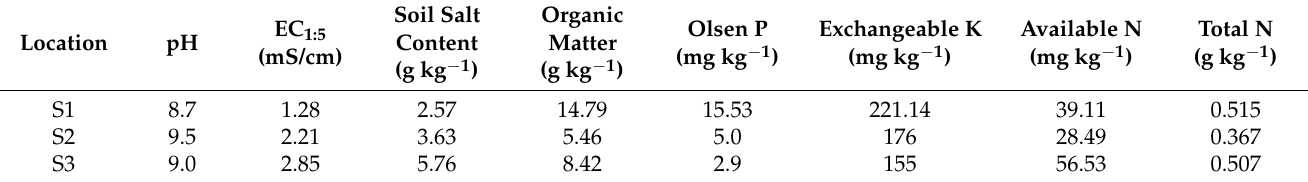
Table 1. Basic conditions of experimental